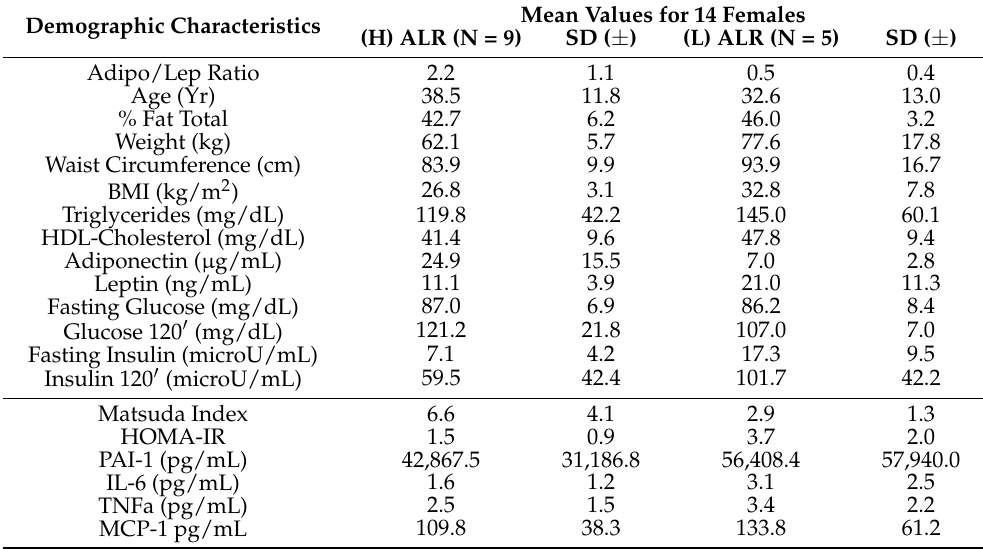
Table 4. Demographics and clinical biochemistries in symptom-free adult volunteers (N = 14).